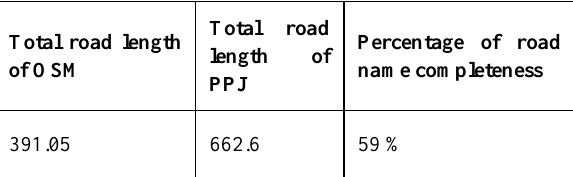
Table 5: Analysis of road name completeness